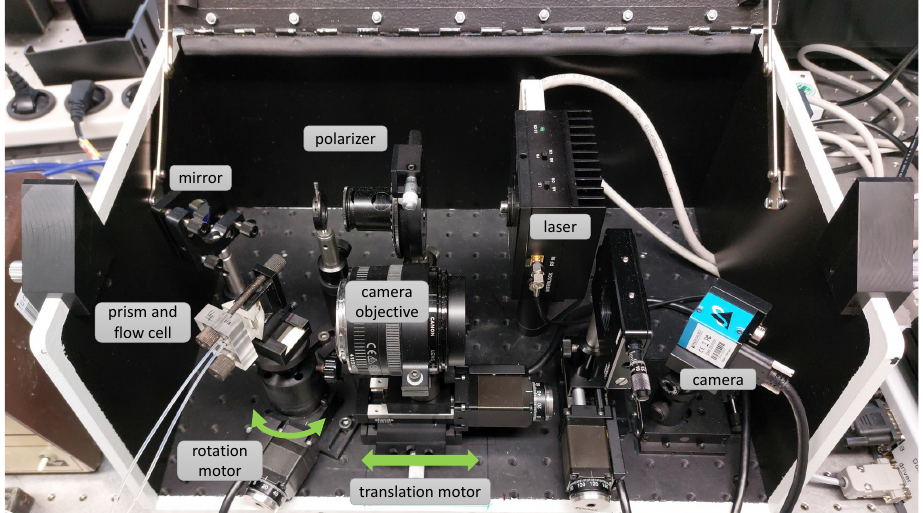
Figure 1. Schematic setup of the primary-version SPR microscopy sensor equipped with a rotation and a translation platform that can be controlled over two stepper motors connected via a USB